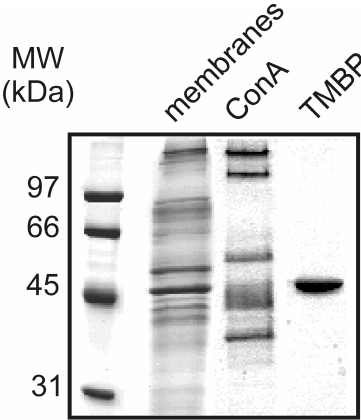
Figure 7. Glycosylation of TMBP. Glycosyl moieties were visualized on acrylamide gels with the fluorescent probe AMAC after hydrolysis of the purified protein with 2 N TFA or 4 N HCl as described in Mat- erials and